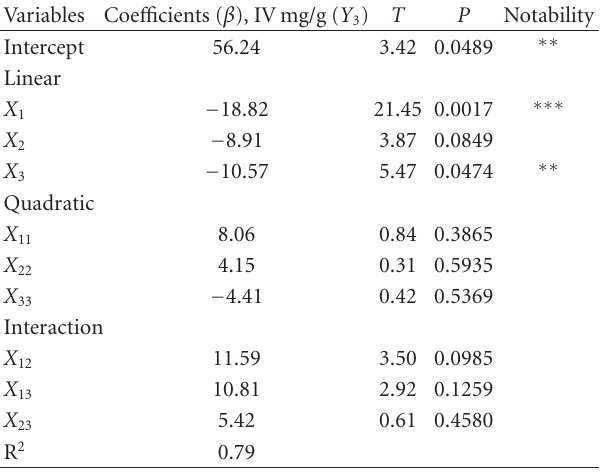
Table 5: Regression coe ffi cients of the predicted quadratic polyno- mial model for response variables of the IVmg/g for the